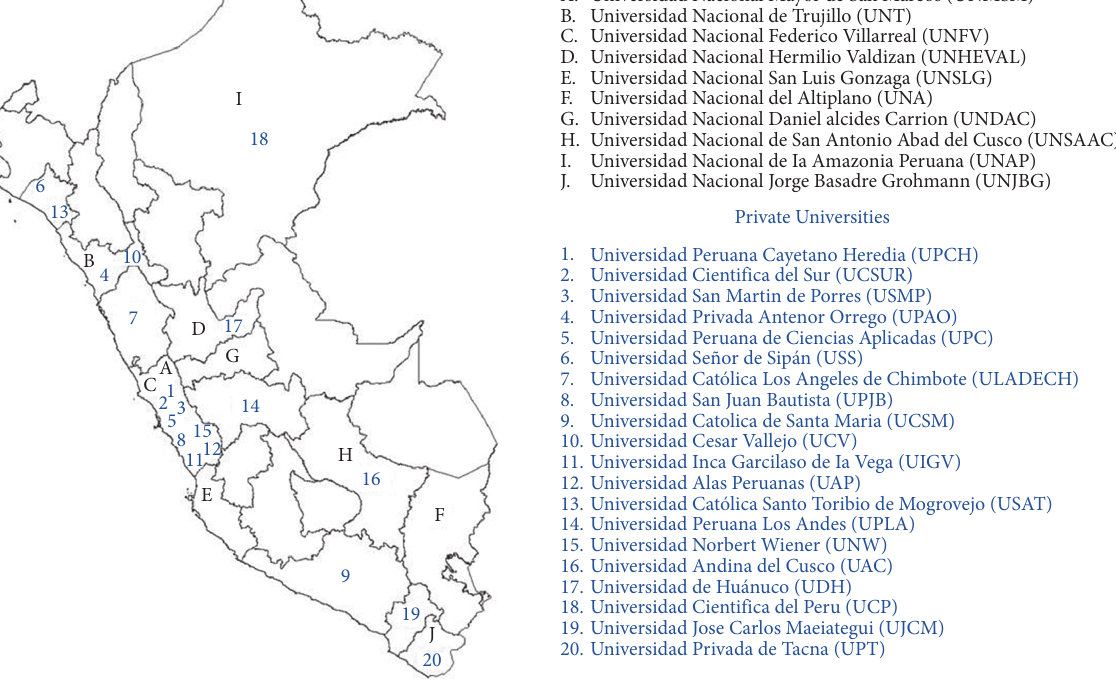
Figure 1: Geographical distribution of all the Faculties of Dentistry of the public and private universities of